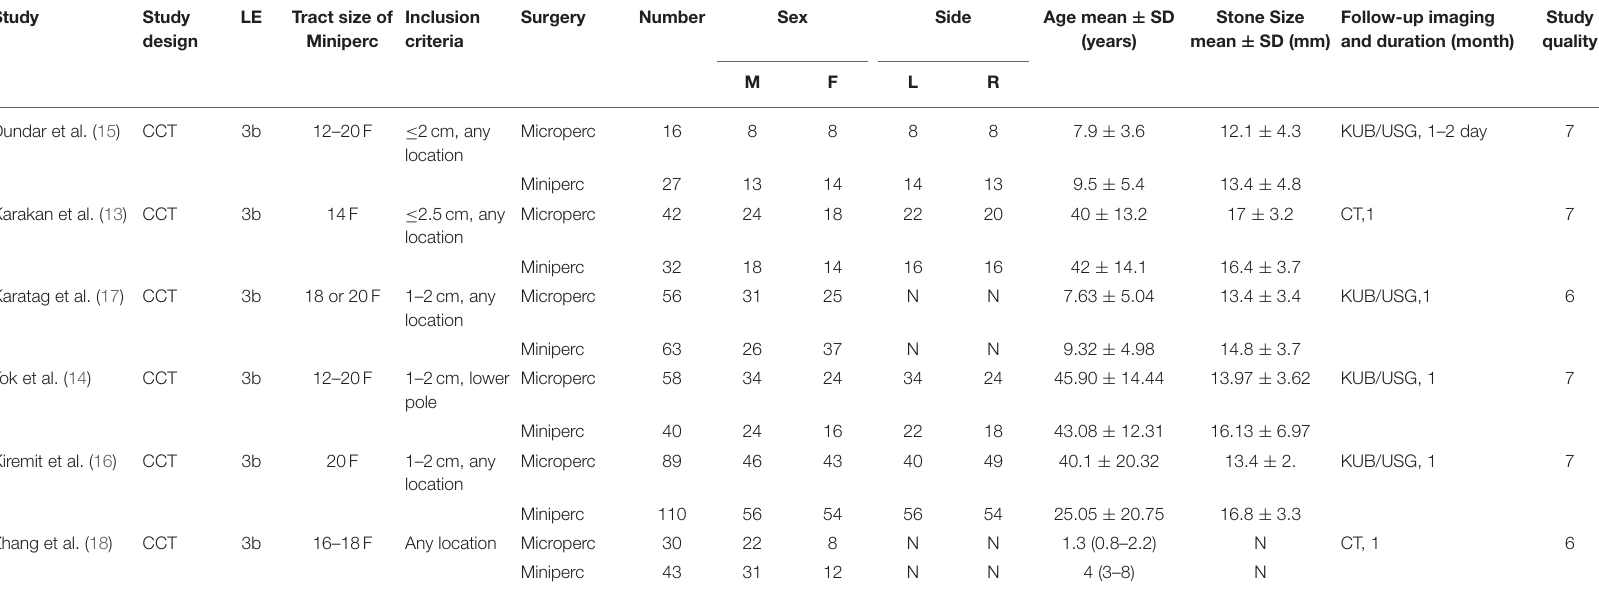
TABLE 1 | Basic characteristics and data of included